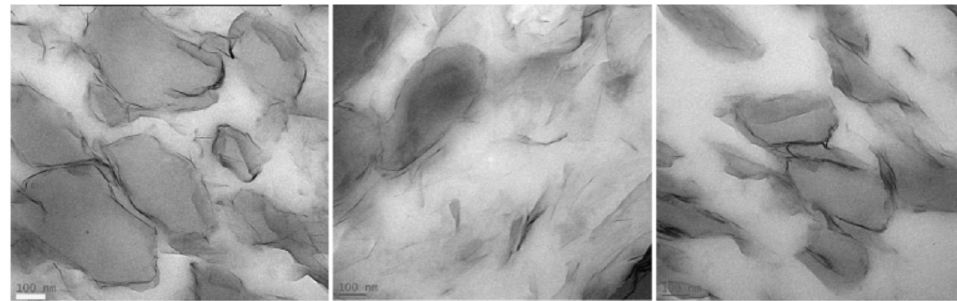
Figure 8. TEM images showing the localization of 5 wt% C30B in PLAT/PBAT 75/25-based nanocomposites prepared with different strategies (from left to right, methods S1, S2, S3). Reprinted (adapted) with permission from Ref. [127] Copyright 2016 Elsevier.